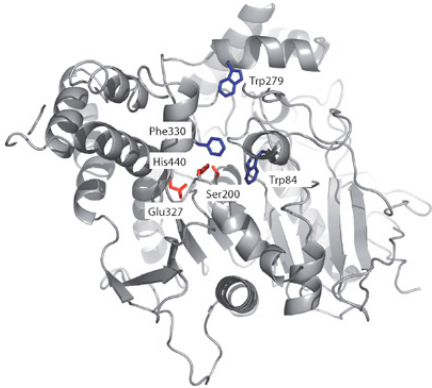
Figure 18. 3D structure of native torpedo californica AChE. The catalytic triad in red, Trp84 in the CAS, Trp279 at the PAS, and the bottleneck residue Phe330 in blue. Reproduced with permission from [99].